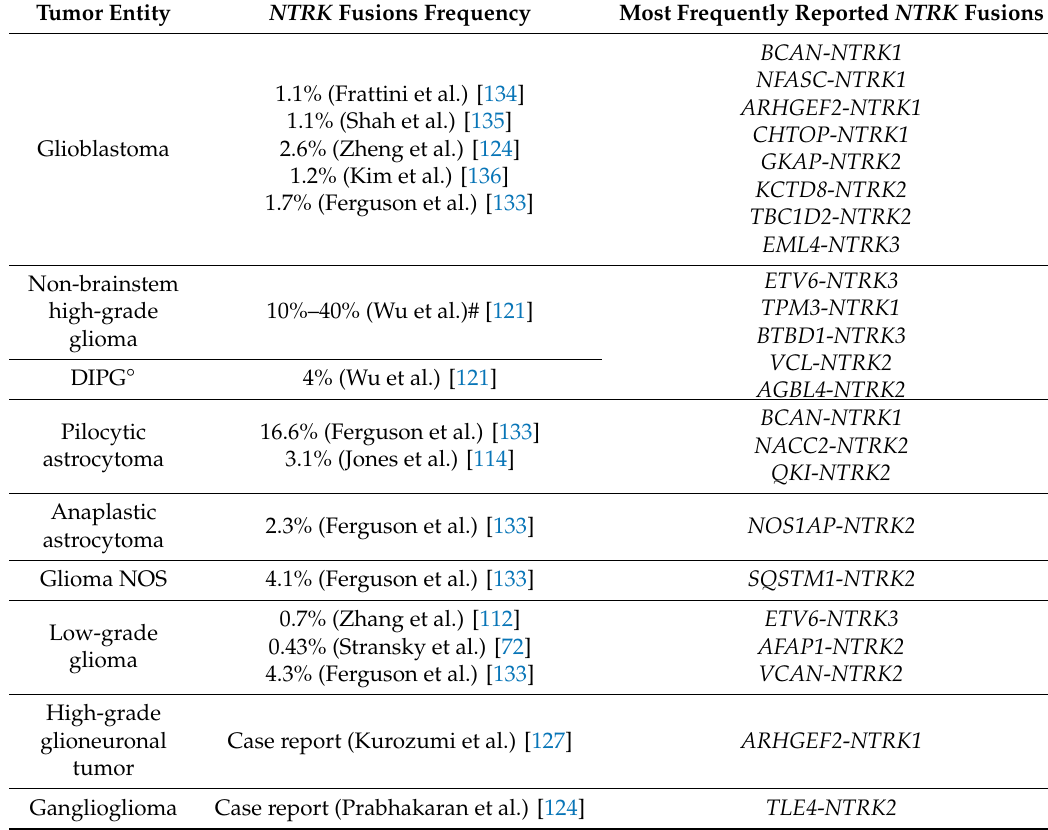
Table 1. NTRK fusions in CNS